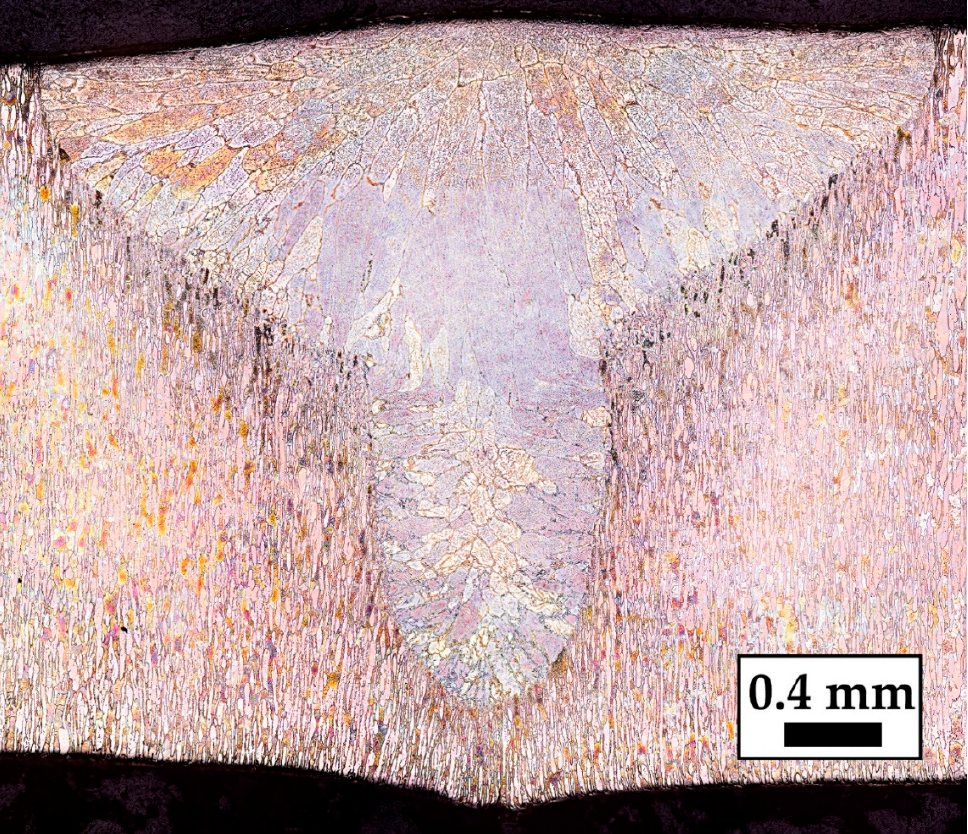
Figure 2. Overview of weld bead of the undeformed sample (electrolytic etching at 20 V with 20% NaOH).